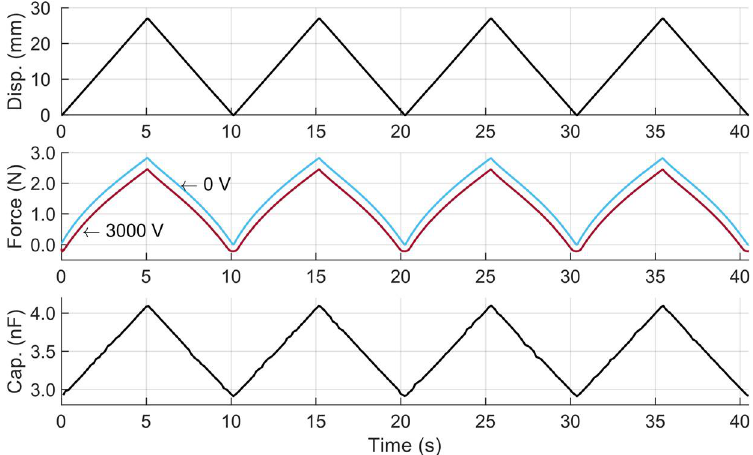
Figure 11. Prescribed displacement ( upper part ), the measured forces for 0 V (blue) and 3000 V (red) ( center part ), and capacitance for 0 V ( lower part ) of the CORDEA specimen 1 over time.